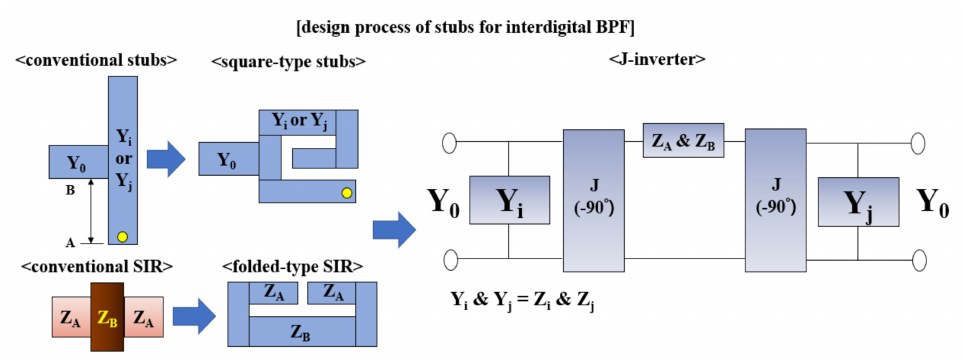
Figure 4. Equivalent circuit of the proposed